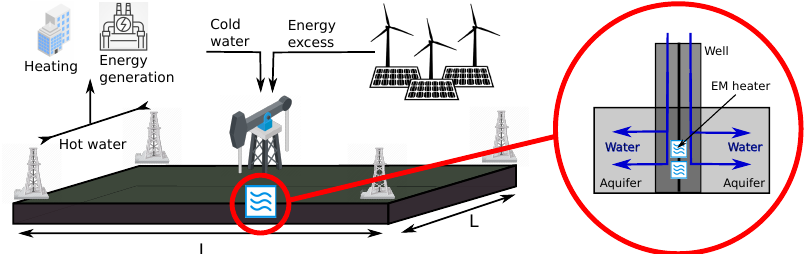
Figure 1. Schematic representation of the proposed